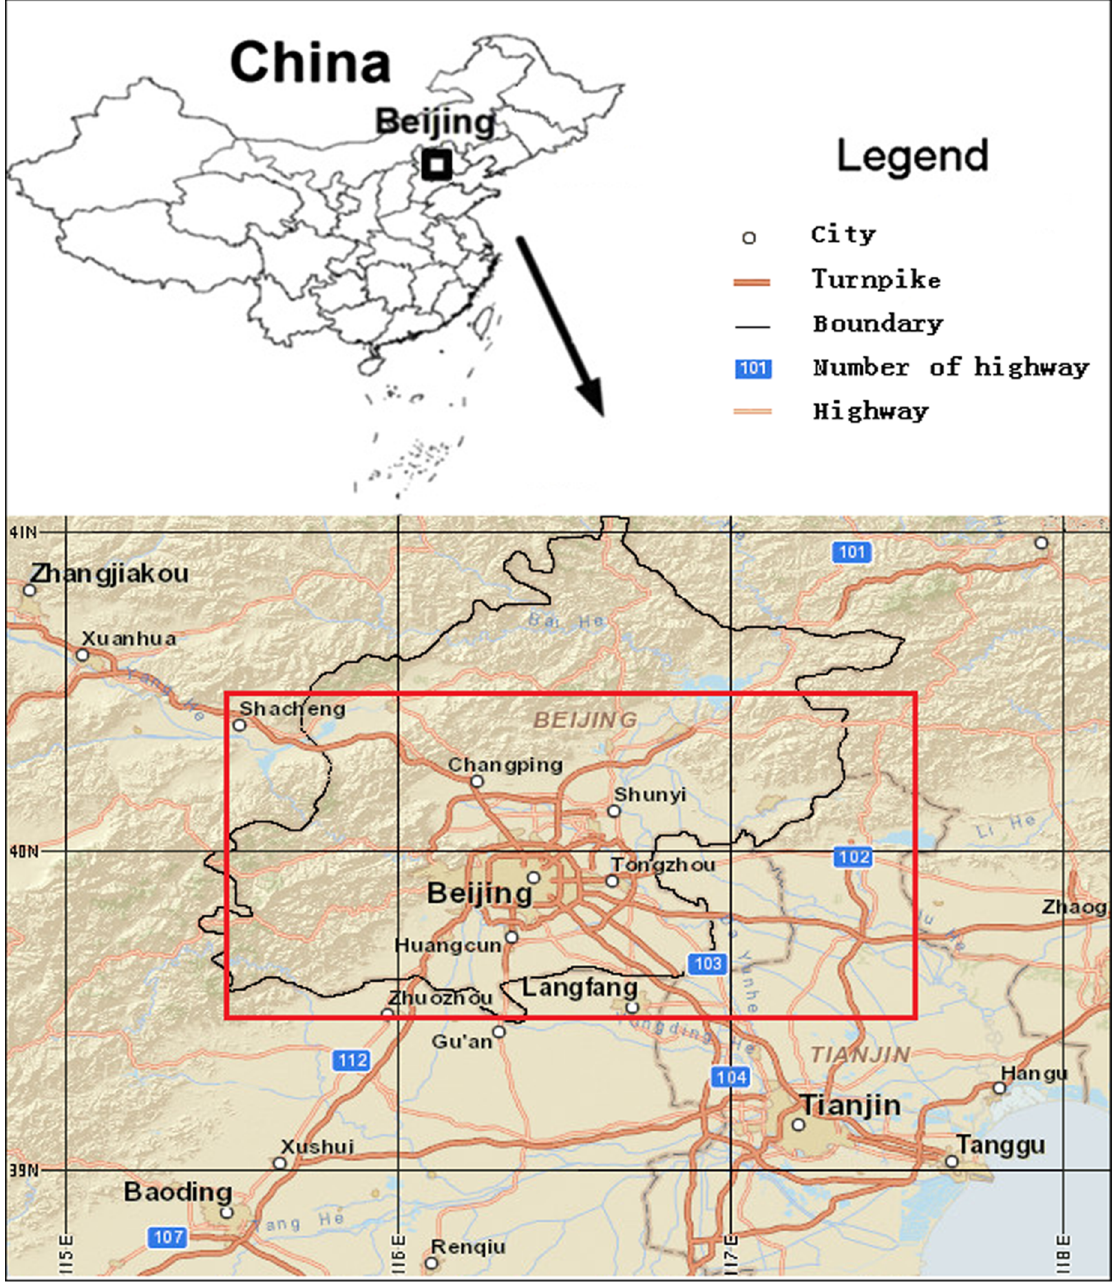
Figure 1. The geographic location of the study area is indicated by the black square on the Chinese national map ( upper ). The study area (115.5°–117.5°E, 39.5°–40.5°N) is indicated by the red polygon ( lower